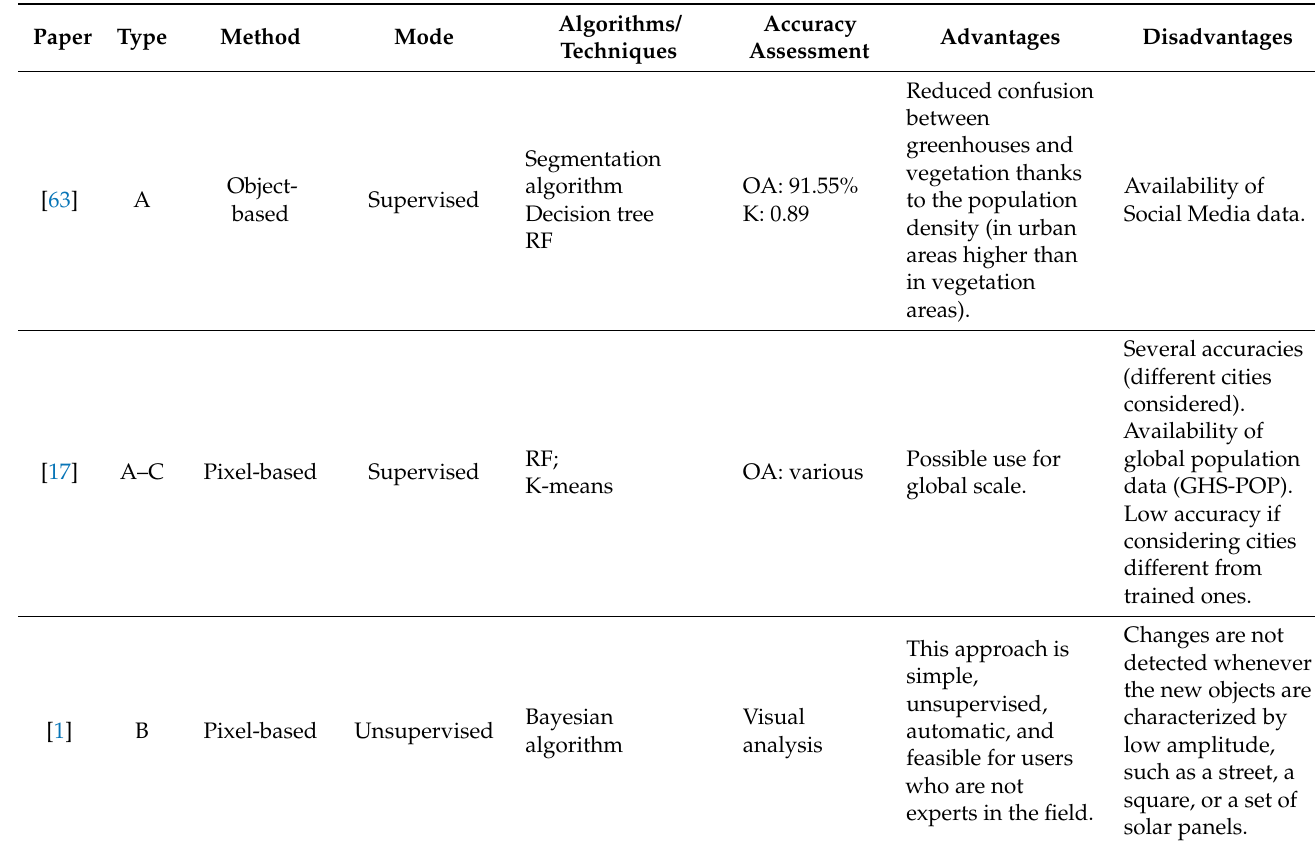
Table 3. Summary of analyzed